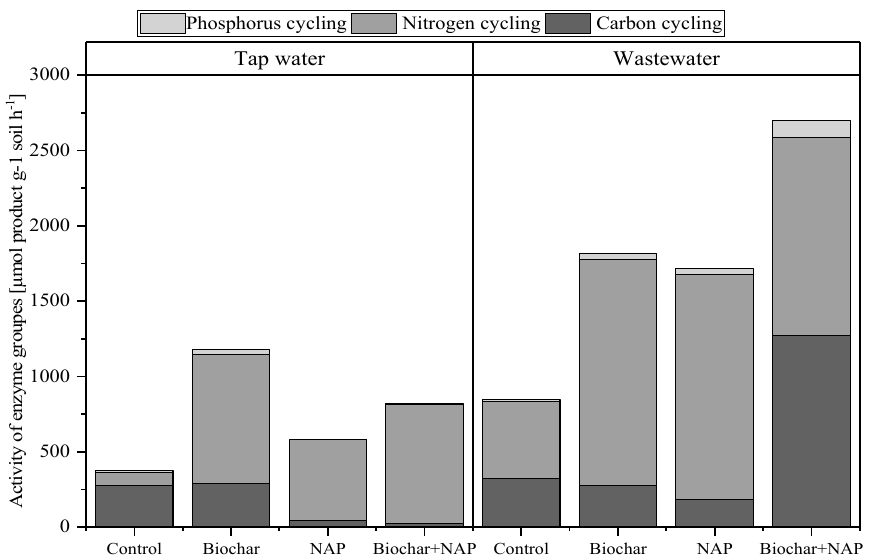
Figure 3. Activity of extracellular enzymatic groups ( µ mol g − 1 product h − 1 ) of C-cycle ( α - glucosidase, β -glucosidase, β -xylosidase and β -cellobiosidase), N-cycle (leucine-aminopeptidase, tyrosine-aminopeptidase, and arginine-aminopeptidase) and P-cycle (acid phosphatase) in the differ- ent soil treatments under tap and wastewater irrigation.